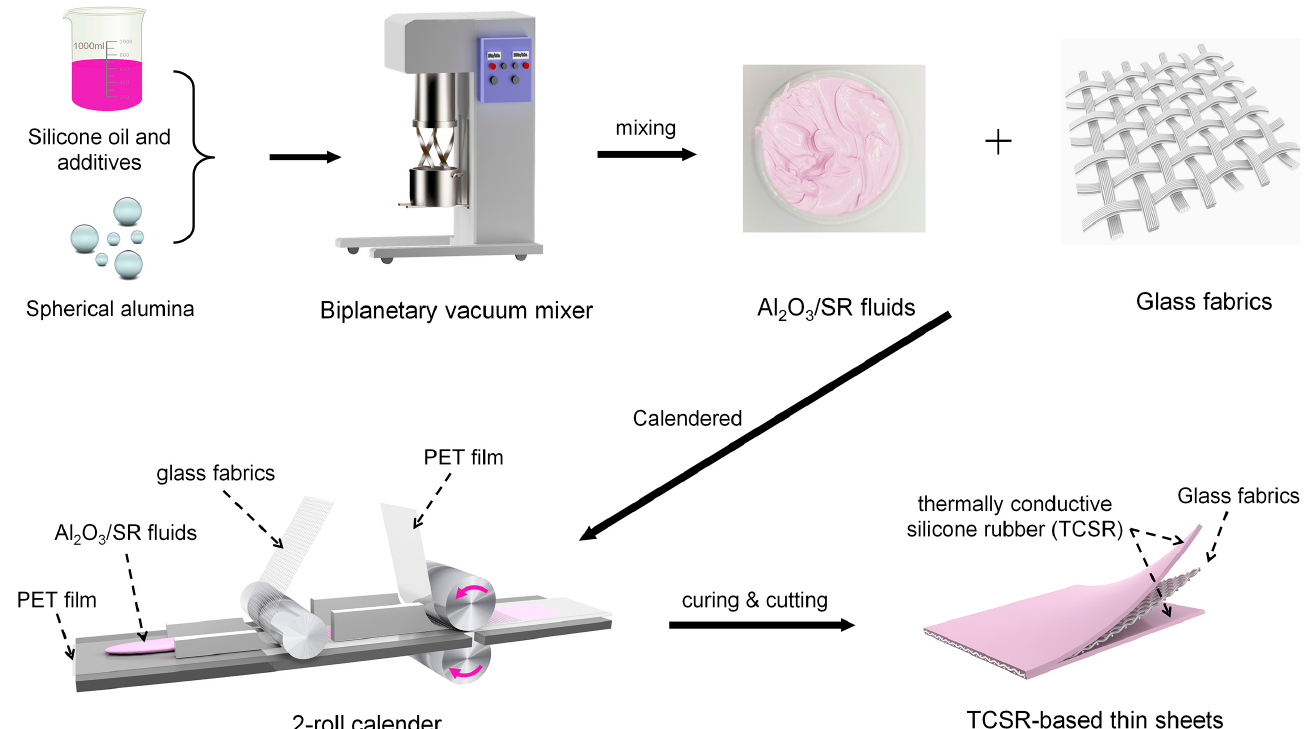
Figure 1. Schematic diagram of the preparation process of TCSR-based thin sheets.